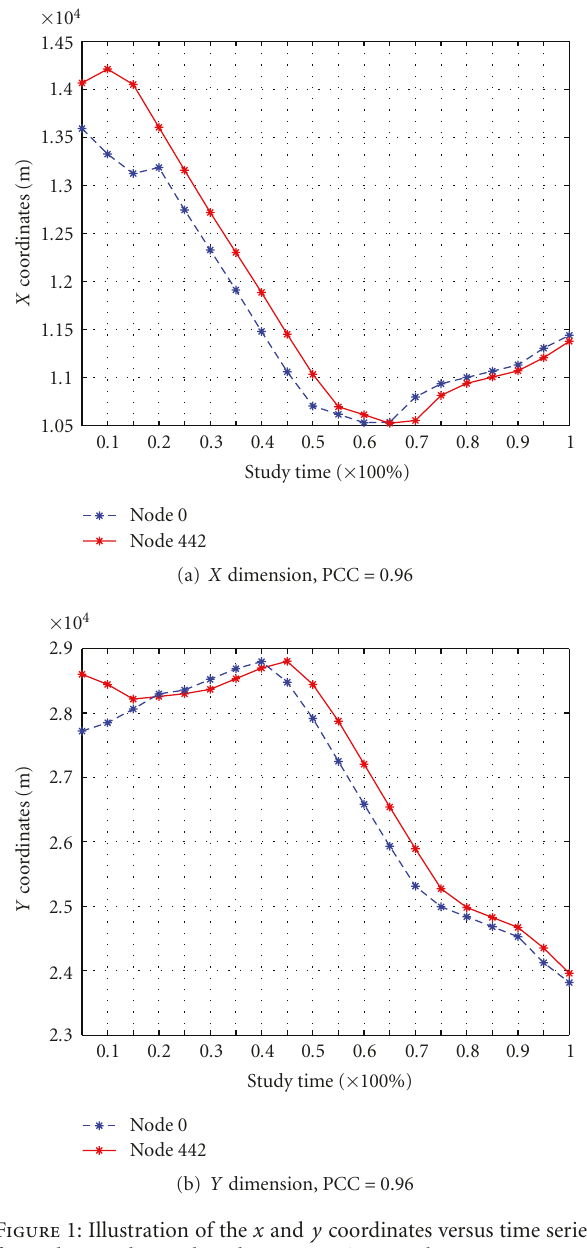
Figure 1: Illustration of the x and y coordinates versus time series for nodes 0 and 442 when they are moving